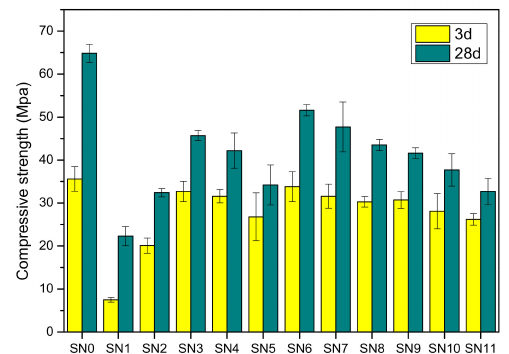
Figure 7. Compressive strength of the cement